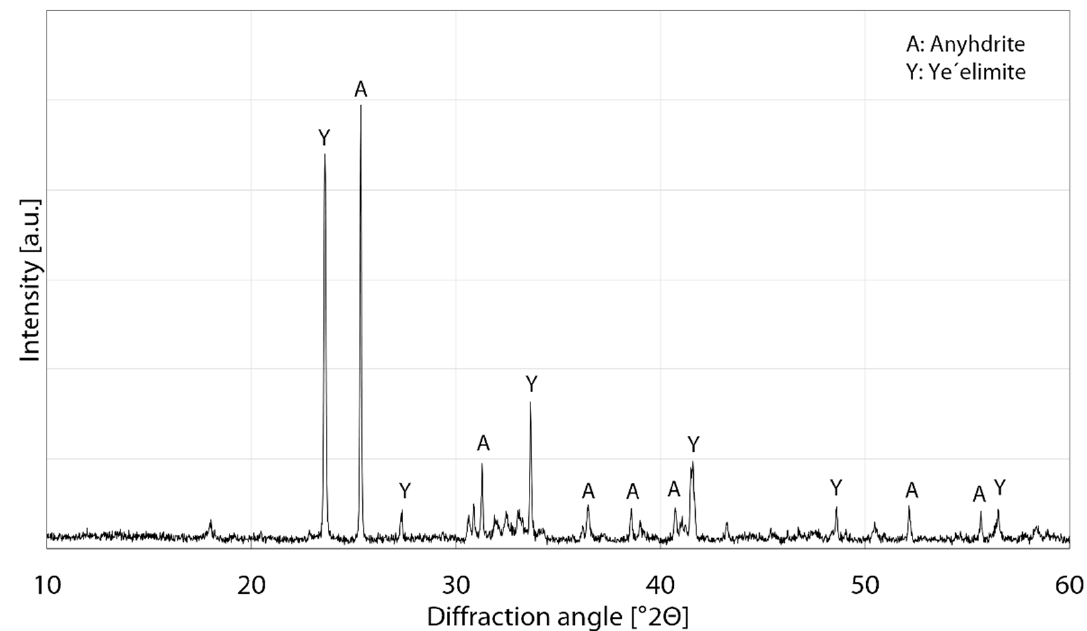
Figure 9. XRD diffractogram of the CSA cement clinker used in this study. The cement was measured as a powder that was stored in a dry environment until the measurement.